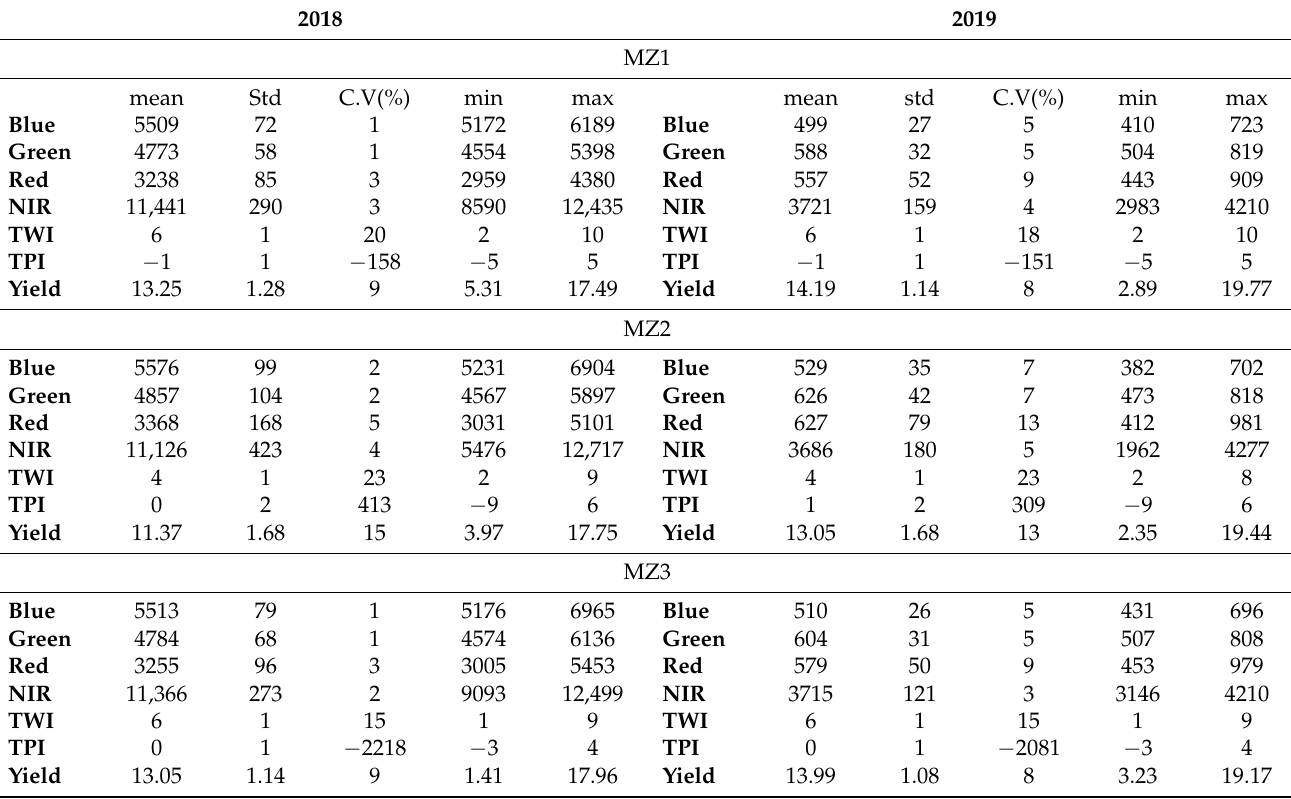
Table 4. Descriptive analysis for spectral bands, TWI, and yield for the years 2018 and